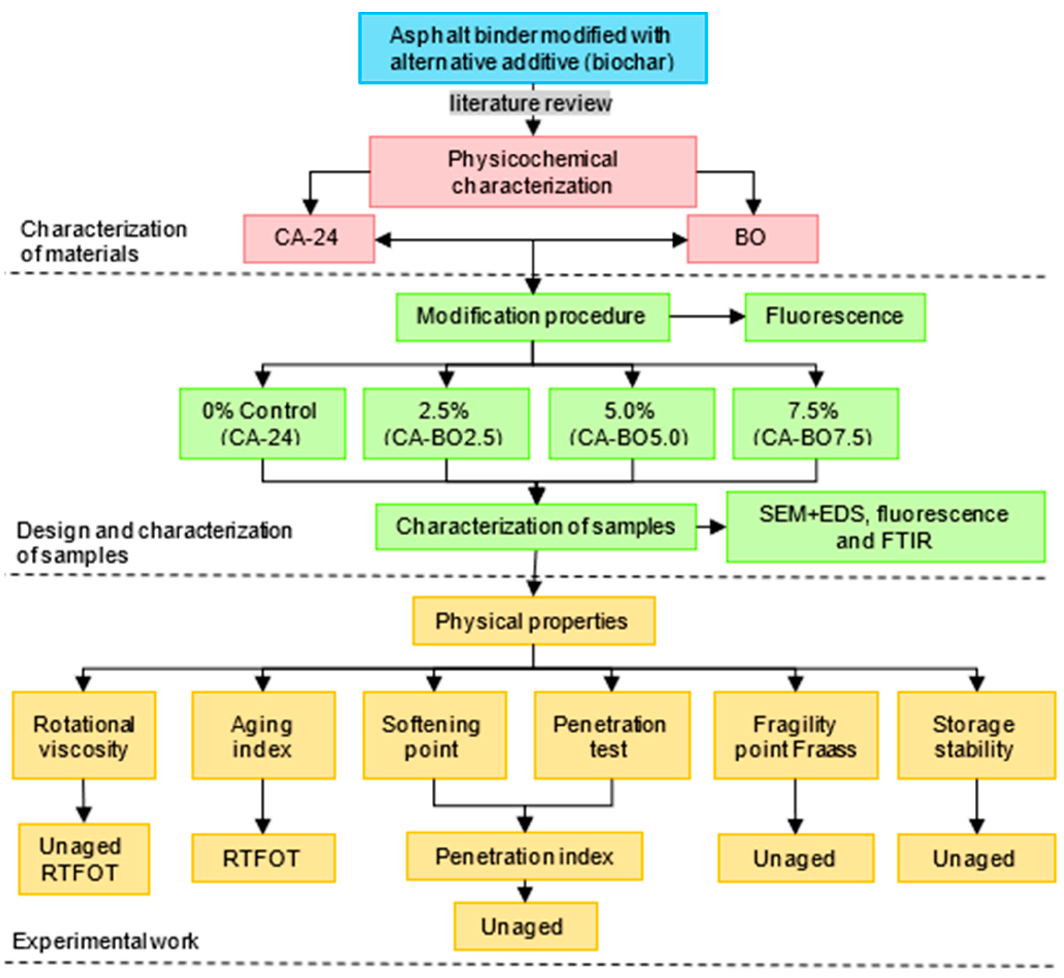
Figure 3. Experimental plan.